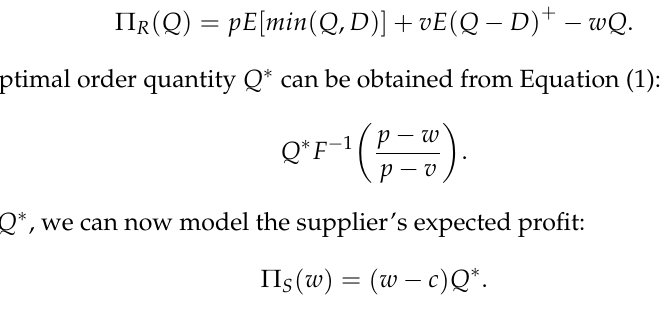
price of per option